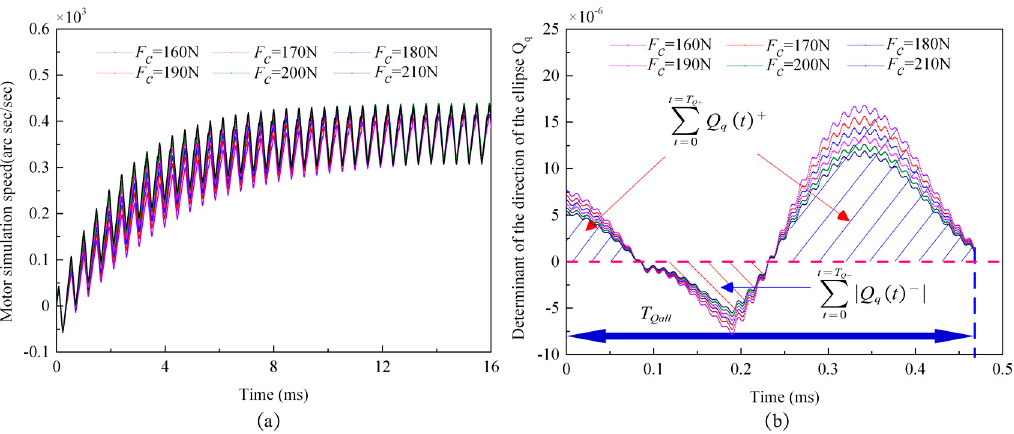
Figure 22. Simulation diagram of the characteristic variables changing with prepressure: ( a ) a simulation diagram of the motor’s average speed, v s , and the motor’s average speed determinant, Q aver , changing with the prepressure; and ( b ) a simulation diagram of the speed volatility determinant, Q vib , and the speed volatility, σ s , changing with the prepressure. After analyzing the six groups of simulation experiments, according to the definition of the aforementioned variables, the conclusions were made and are as shown in Figure 23.